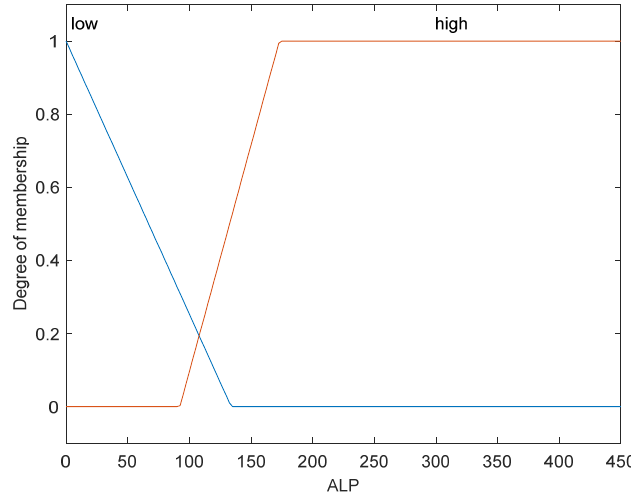
Figure 6. Membership function of ALP as input variable.